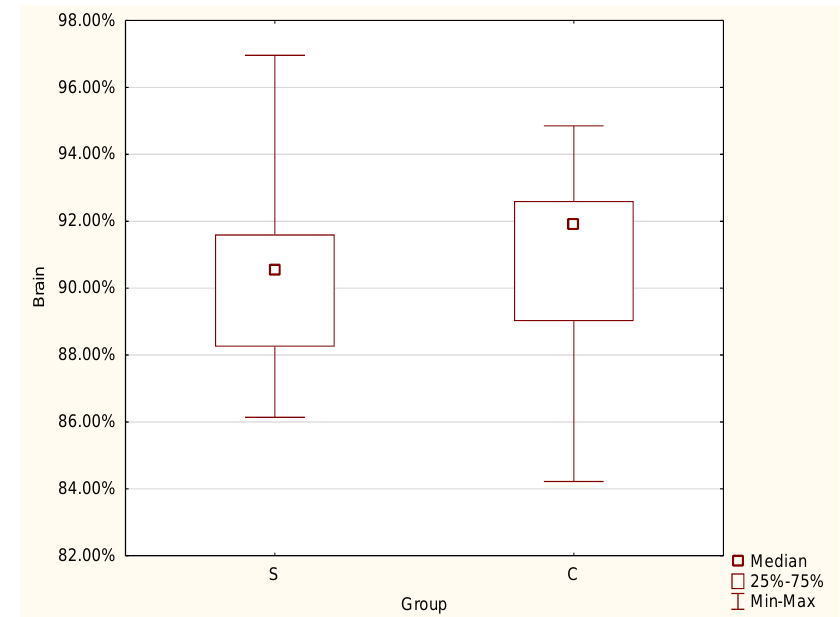
Figure 6. Differences in brain volume between the control and study group.